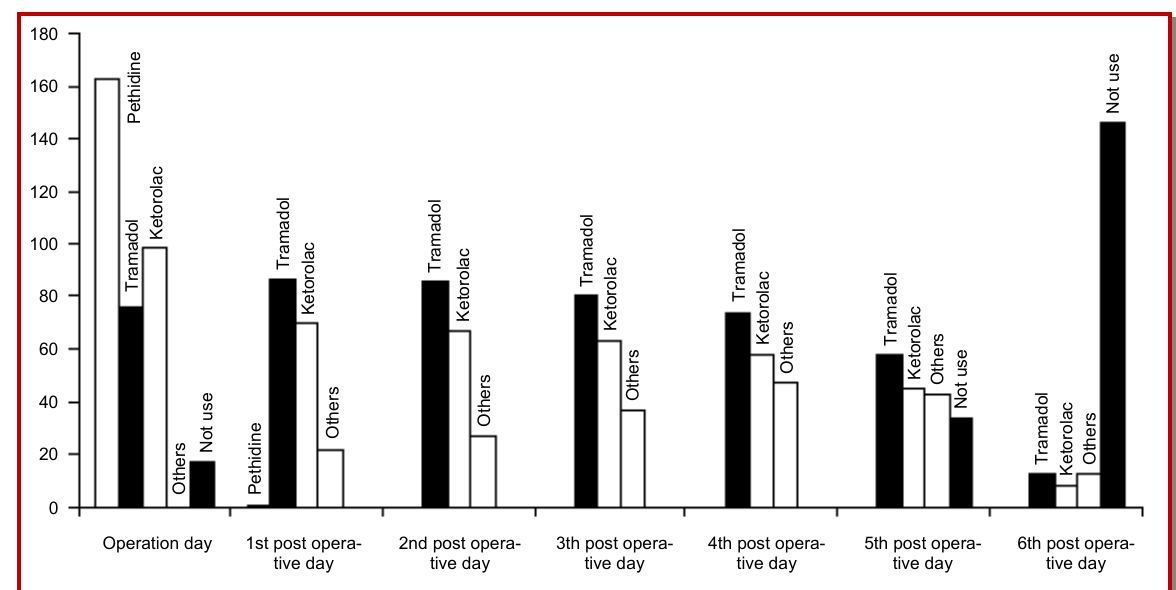
Figure 1: Distribution of the patients admitted in the hospital according to analgesics used from operation day to sixth post- operative